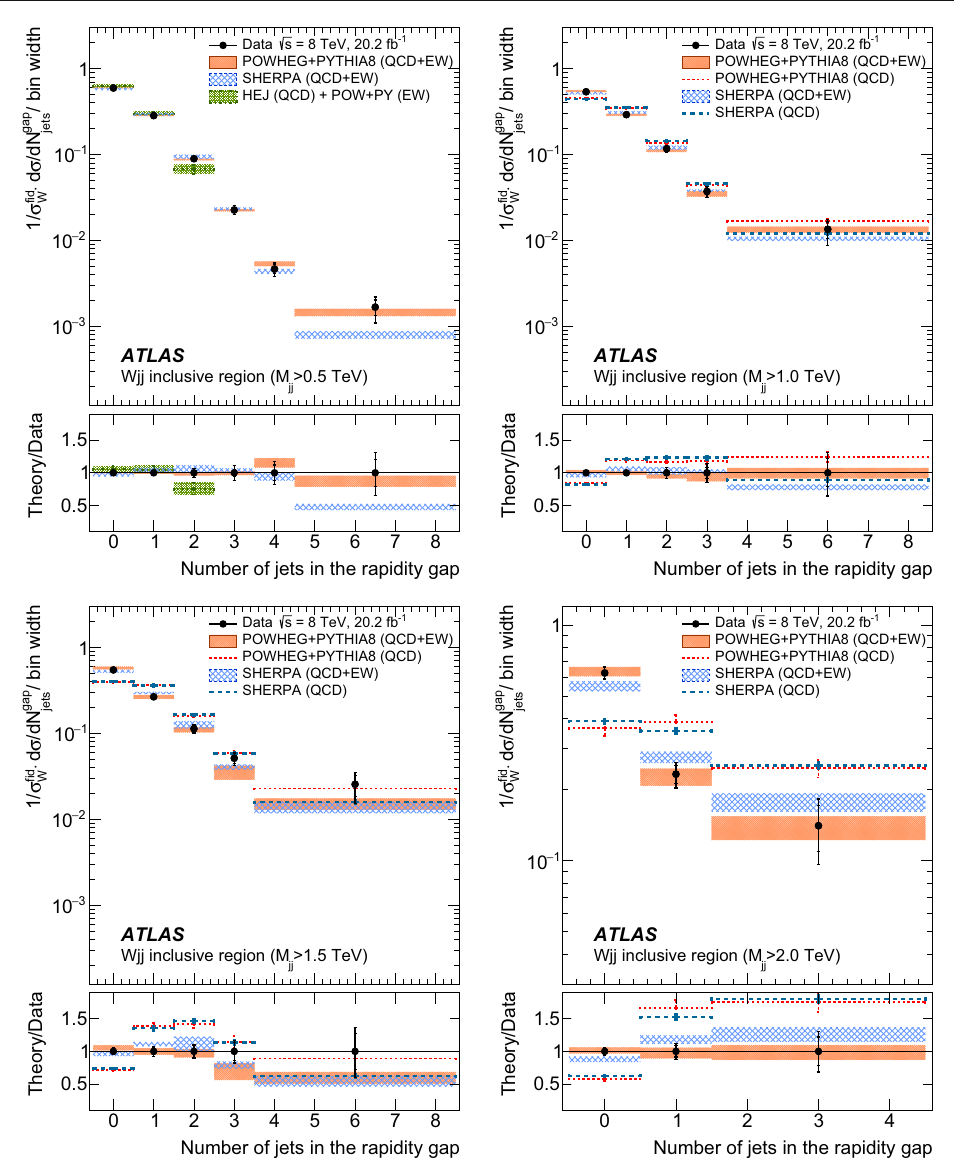
right ). Both statistical ( inner bar ) and total ( outer bar ) measurement uncertainties are shown, as well as ratios of the theoretical predictions to the data (the bottom panel in each